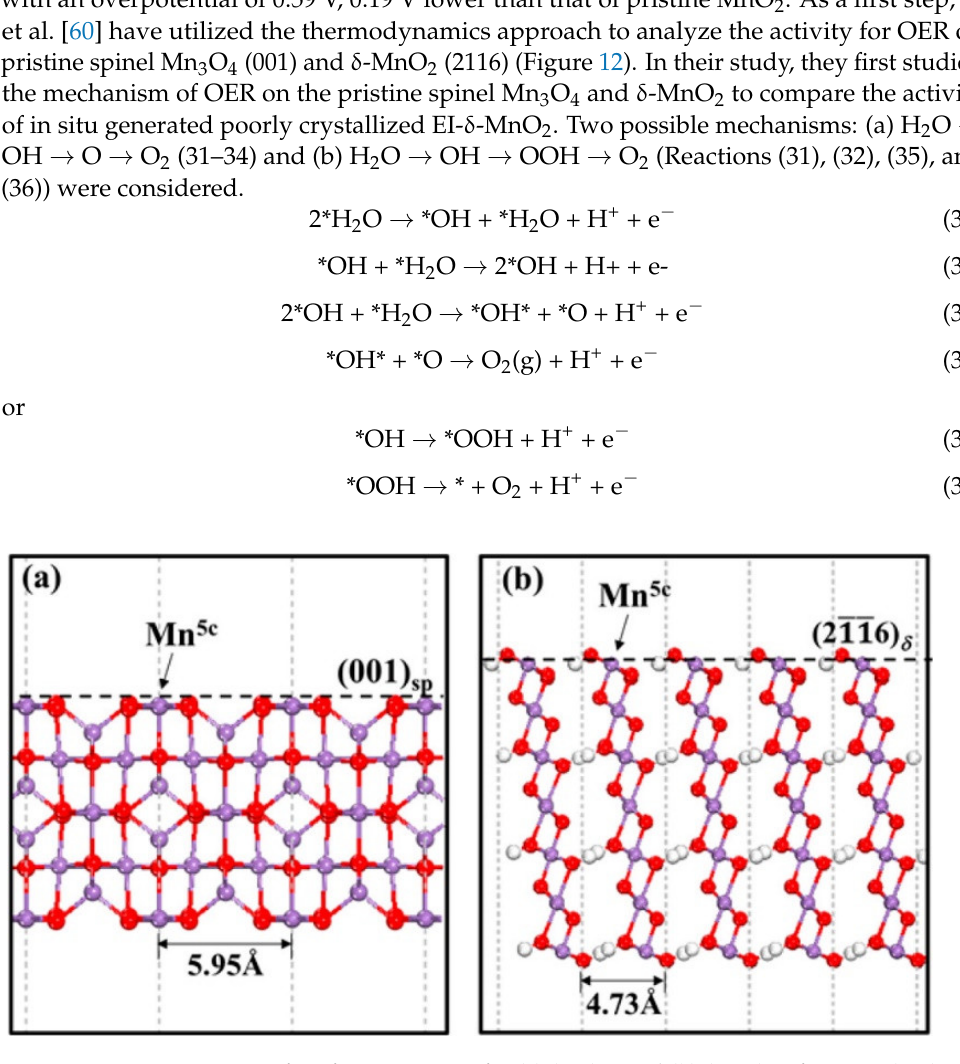
Figure 12. Representation of surface structures for ( a ) (001) sp and ( b ) (2116) δ of Mn 3 O 4 (001) and δ-MnO 2 (2116), respectively. Color code: O, red; H, white, Mn, violet. (Reprinted from ref. [60] with permission from American Chemical Society. Copyright © 2018, American Chemical Society).